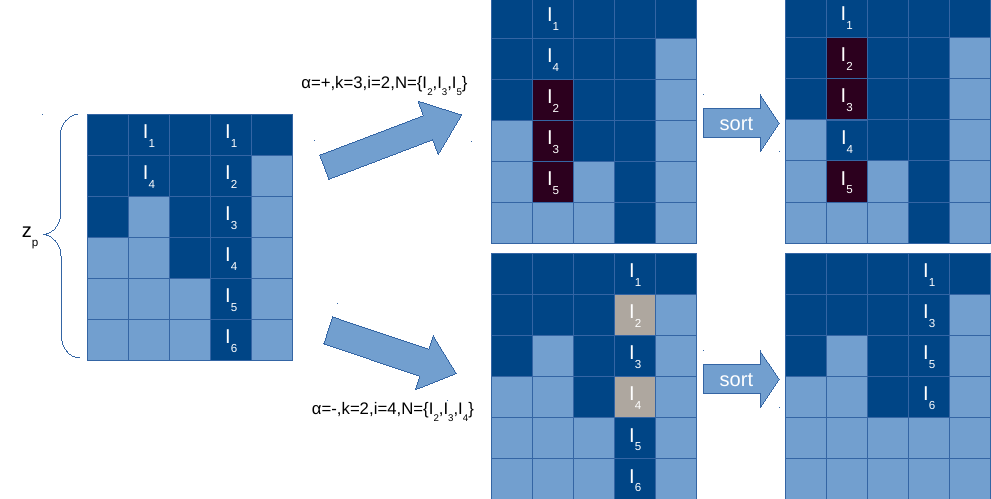
Figure 7. Illustration of application of a plasticity rule in the synapse matrix with compressed representation. Light blue cells in the synapse matrix are empty values (0), dark cells are positions with values greater than 0 (i.e., with neuron label). Two examples are give, in case of adding new synapses ( top ) and in case of deleting synapses ( bottom ). We sort the synapses per column for more